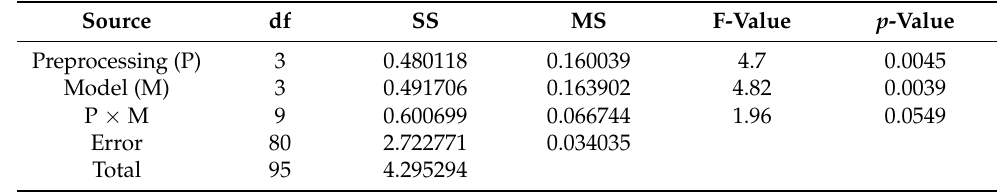
Table 4. Analysis of variance of percentage of correctly classified six Amaranthus sp. from four different preprocessing and four different classification model using reflectance spectra.